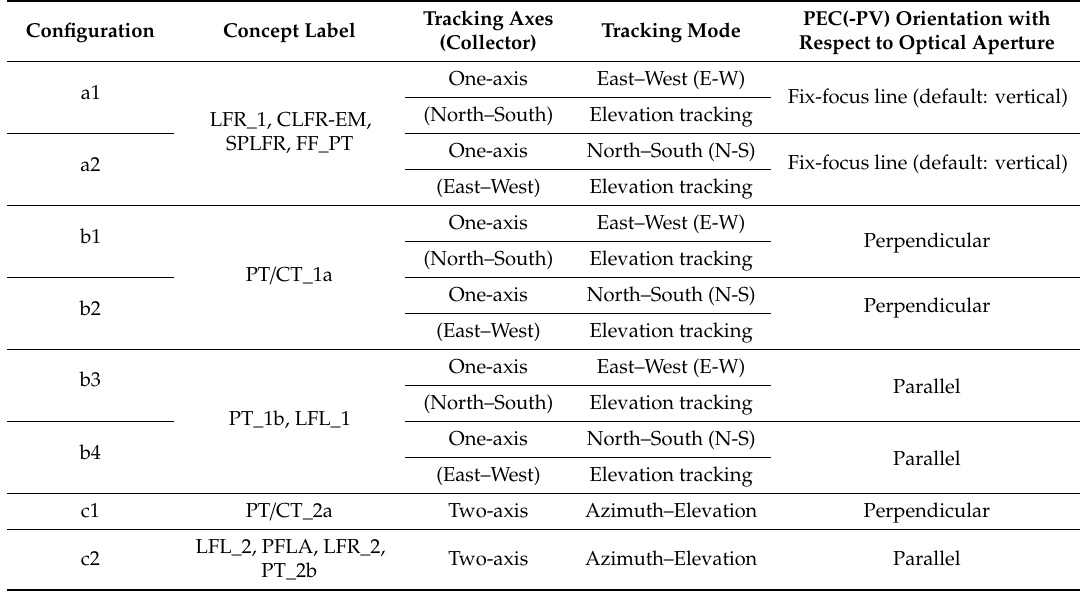
Table 5. Description of geometrical